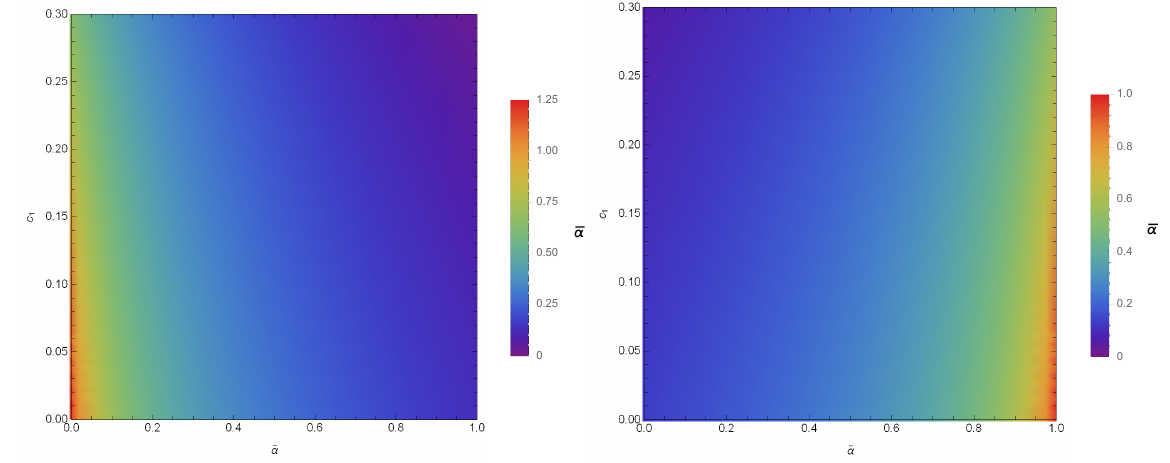
Figure 2. Color-indexed variations of the coefficient (¯ a ) with ˜ α and c 1 ( left ) for PPL and ( right ) for √ PPM. Here, we set c 0 = 3 c 1 d + 1, d = 1, and Λ = − 1.